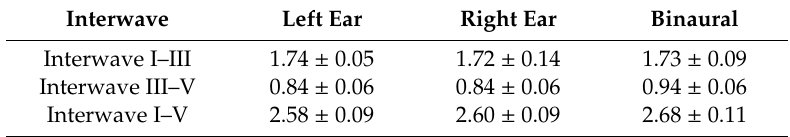
Table 2. Brainstem auditory evoked potentials interwave I–III, III–V and I–V (in ms) in healthy adult anesthetized raccoon dogs.